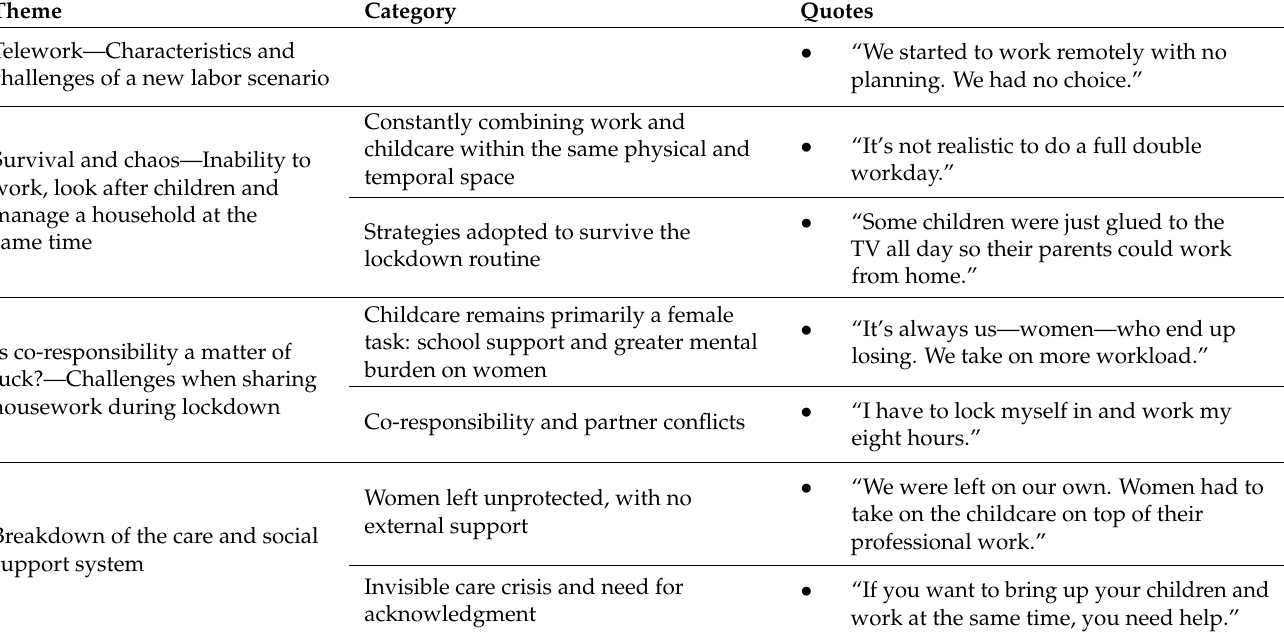
Table 3. Themes, categories, and